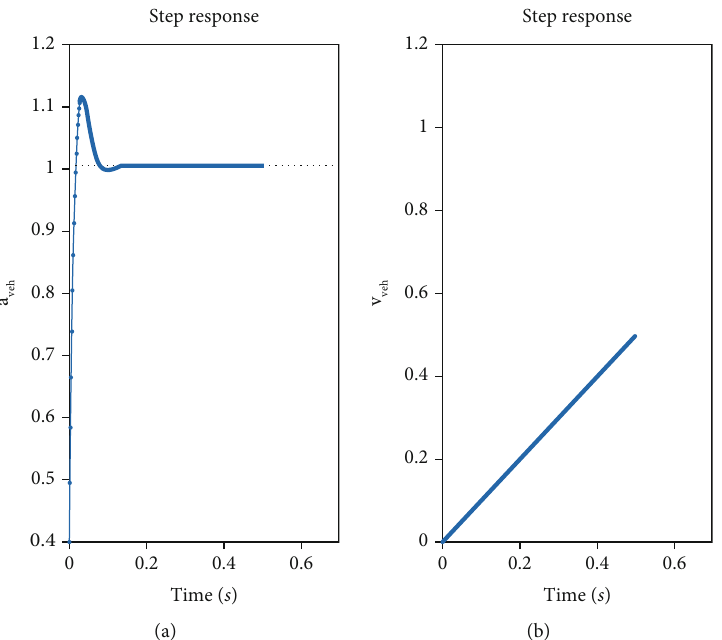
Figure 8: Acceleration (a) and vehicle velocity (b), respectively, in closed-loop PID-ZN (1).